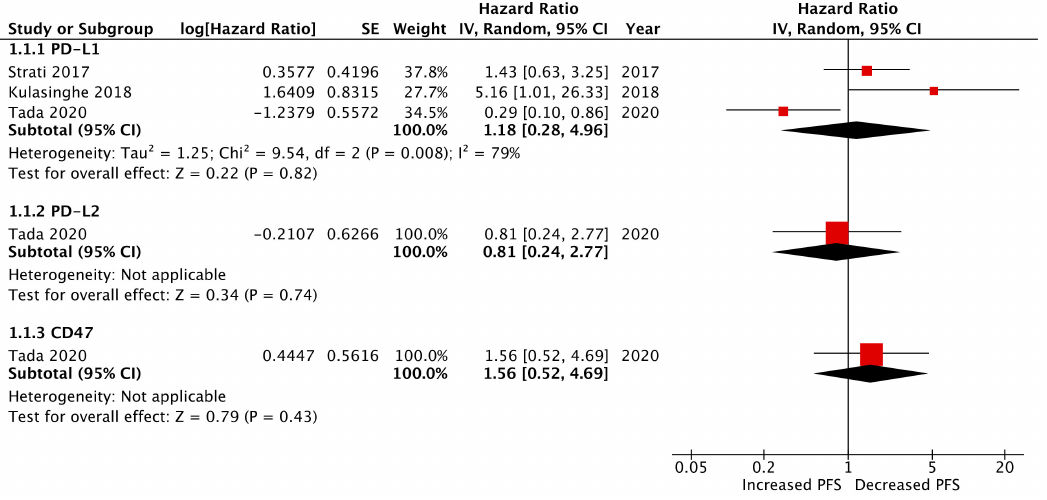
Figure 2. Forest plot and meta-analysis of pre-treatment CTC immune-marker expression as a biomarker of progression-free survival (PFS): Meta analysis performed on CTC PD-L1 expression (presented data may vary from Table 2 due to conversion